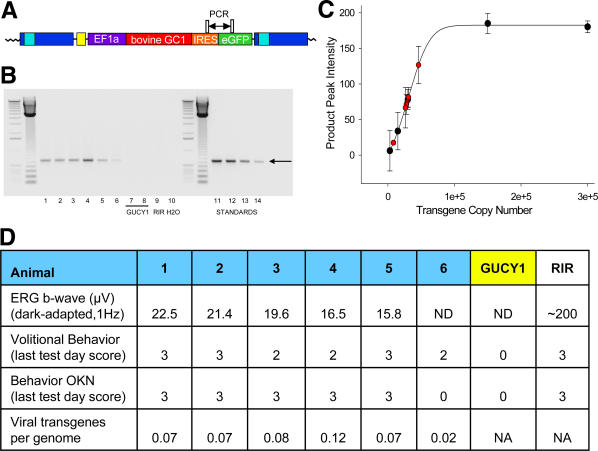
Quantitative Genomic PCR Estimate of Integrated Viral Trangenes per Genome(A) Diagram of integrated viral transgene and location of PCR primers spanning the IRES-eGFP junction that were used to amplify the transgene.(B) Ethidium-bromide-stained gel showing 638-bp product (indicated by arrow) amplified from the experimental and standard reactions. Lanes 1–6 contain samples amplified from the six treated animals exhibiting restored sight. No product was observed in untreated GUCY1*B (lanes 7 and 8) or wild-type (lane 9) chickens. A blank water control is shown in lane 10. Lanes 11–14 contain product amplified from 300,000, 150,000, 30,000, and 15,000 copies of the transducing vector. DNA size ladders, 1 kb and 123 bp, were run to the left of the samples and standards.(C) Plot of amount of product obtained from the standard PCR reactions (black) best fit with a sigmoid curve (f = y
0 + a/(1 + exp(−(x −x
0)/b))c with r
2 = 0.999 . The products obtained from each experimental sample (red) fell within the linear portion of the amplification curve, and the number of transgenes present in each sample was calculated using the equation for the best-fit curve. Individual values plotted are mean ± SEM (n = 3).(D) Comparisons of integrated viral transgenes per genome, dark-adapted ERG b-wave amplitudes (1 Hz), volitional behavior scores, and optokinetic reflex scores. The data for the ERG and behavioral tests were collected at the end of the 6-wk study period. The results for the six treated animals exhibiting sight and for age-matched untreated GUCY1*B and wild-type RIR animals are shown. NA, not assayed; ND, not detected.